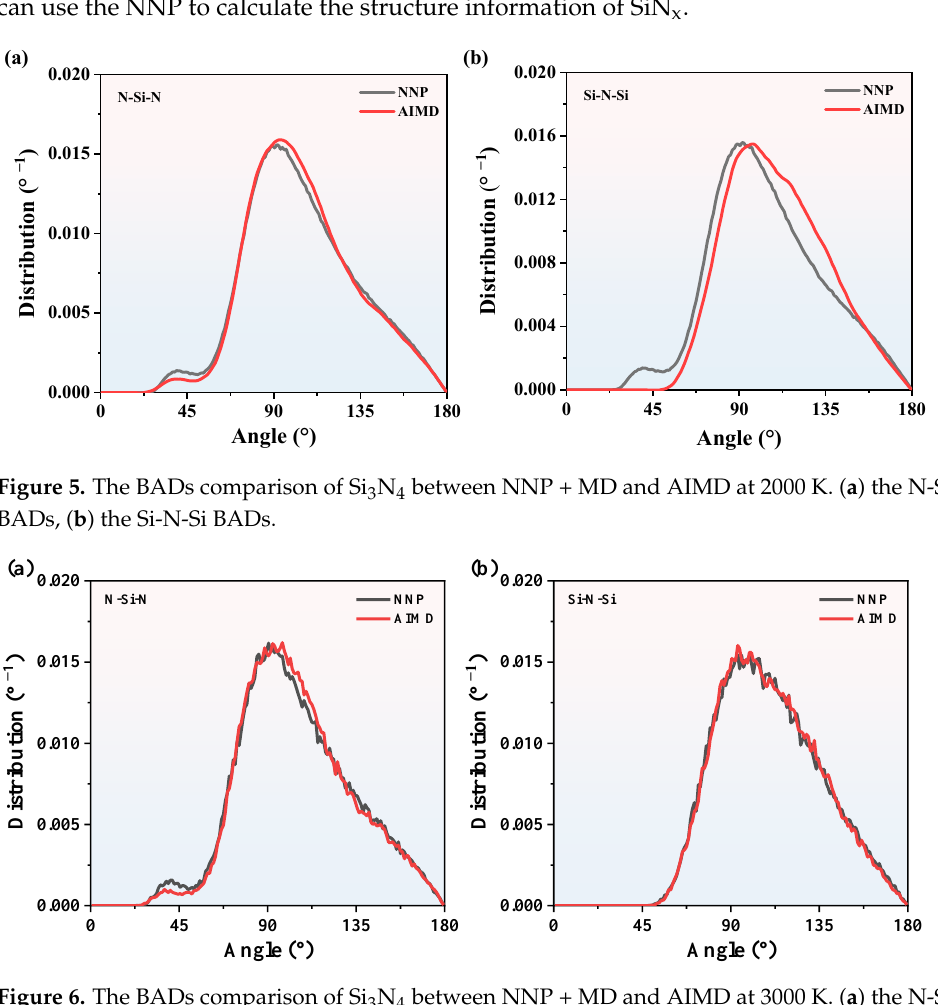
Table 1. The simulation parameters in SiN x heating